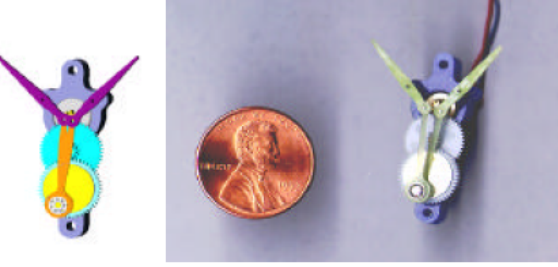
Figure 7. Internal transmission structure of Microbat.